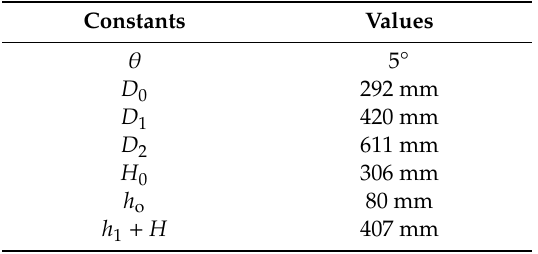
Table 2. The values of constants for the model.